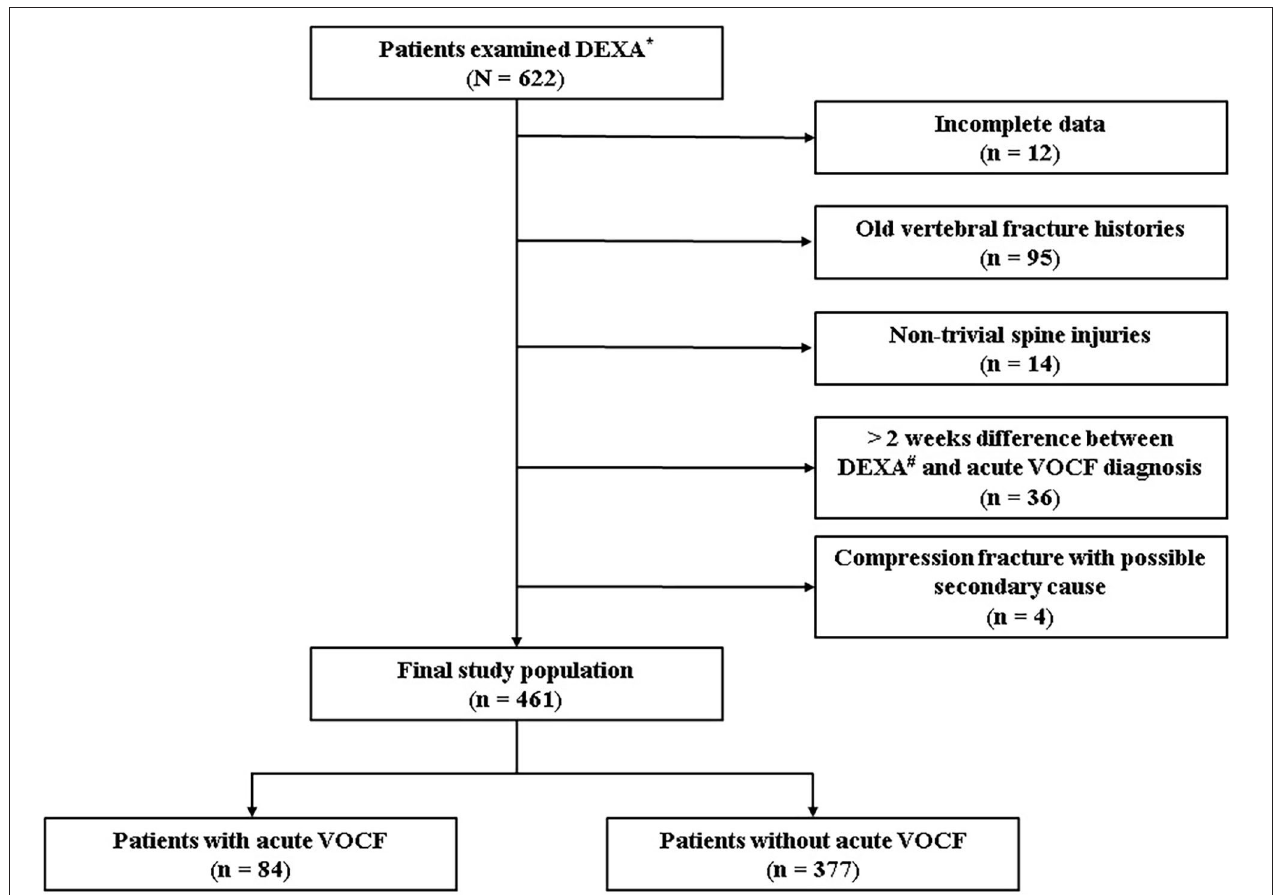
FIGURE 1 | Flowchart. *Dual energy X-ray absorptiometry, # vertebral osteoporotic compression